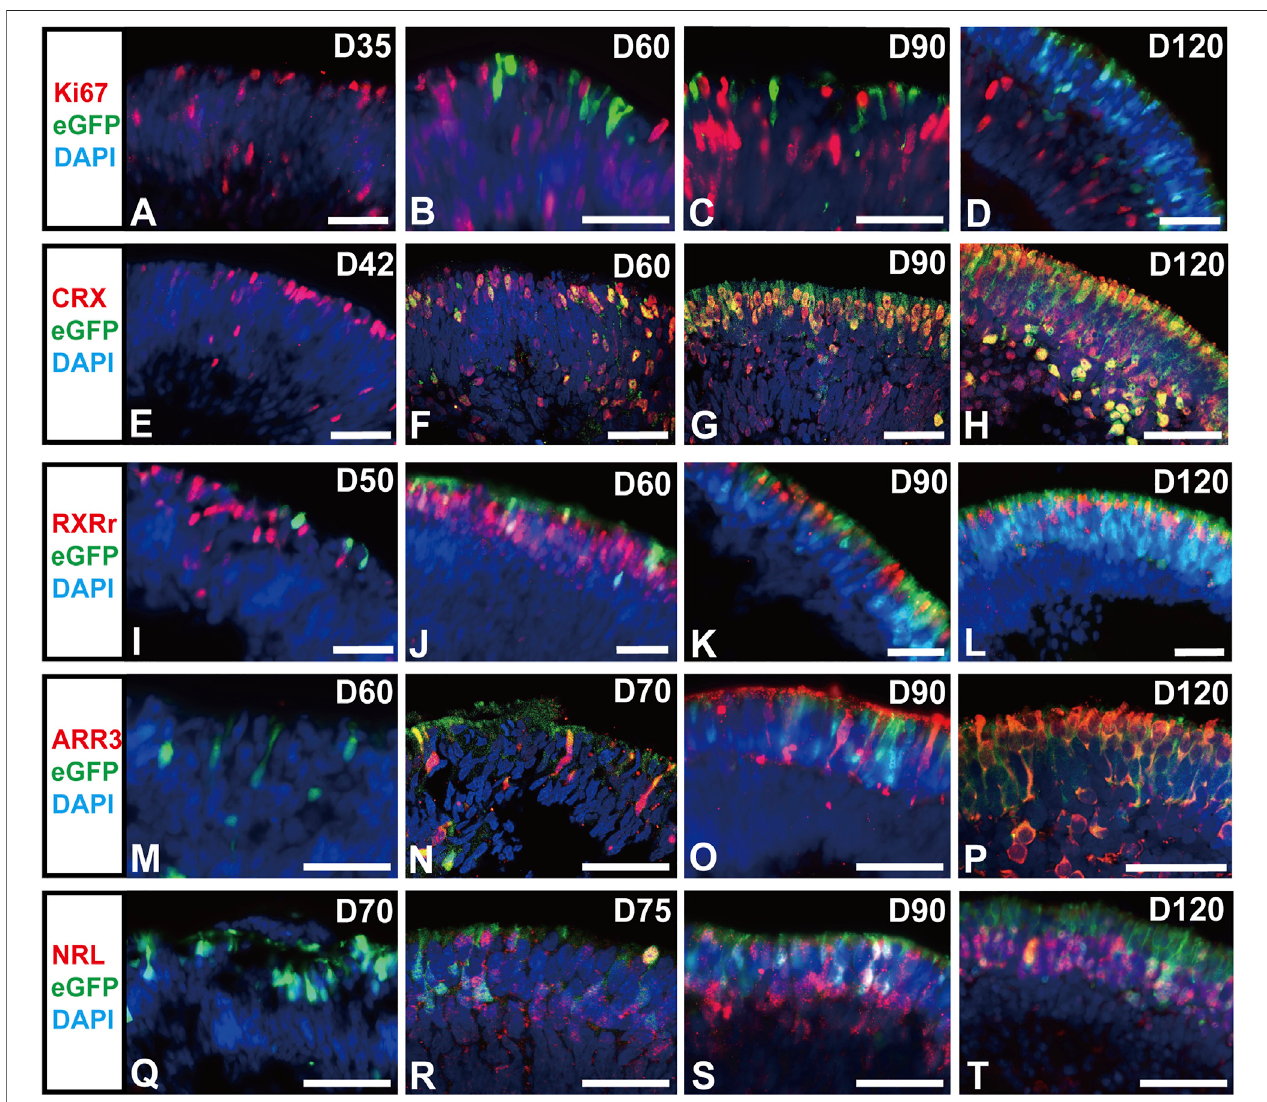
FIGURE 3 | RCVRN-eGFP labels postmitotic photoreceptor precursors in early-stage retinal organoids. (A – D) Immuno fl uorescence (IF) images showed RCVRN- eGFP+ cells did not express the proliferation marker Ki67 in the reporter retinal organoids (ROs). (E – T) IF images showed the expression of photoreceptor precursor markerCRX,coneprecursormarkerRXRrandARR3,androdprecursormarkerNRLintheeGFP+cellsinearly-stageROsyoungerthanD120.Nucleiwerestainedwith DAPI. Scale bars, 50 μ m (A – T) .